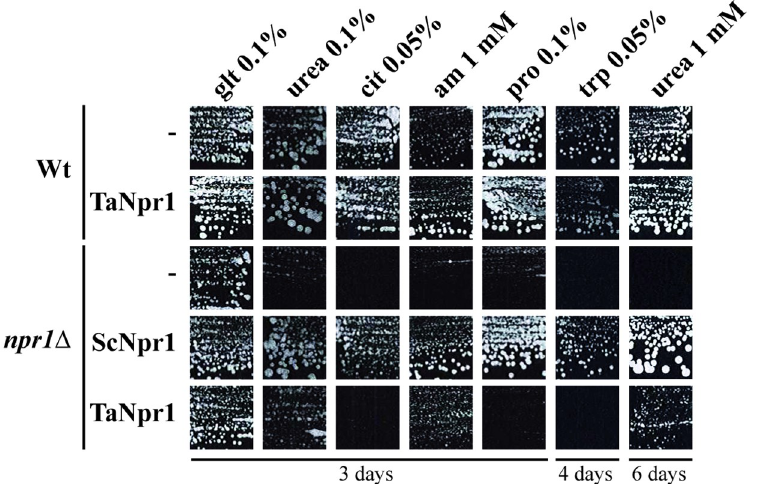
Fig 2. Complementation tests of S . cerevisiae npr1 Δ cells with T . atroviride NPR1 in the presence of several nitrogen sources. S . cerevisiae wild type (Wt; ura3 , 23344c) and npr1 Δ ( npr1 Δ ura3 , PVV357) cells were transformed with the empty plasmid YEplac195 (-), YCpScNpr1 [8] or with YEplac195-TaNpr1p. Cells were grown in minimal buffered (pH 6.1) medium containing 3% glucose as the carbon source and glutamate (glt) 0.1%, ammonium (am) 1 mM, proline (pro) 0.1%, urea 0.1% or 1mM, citrulline (cit) 0.05% or tryptophan (trp) 0.05% as the nitrogen sources. Plates were incubated for 3, 4 or 6 days at 29˚C.